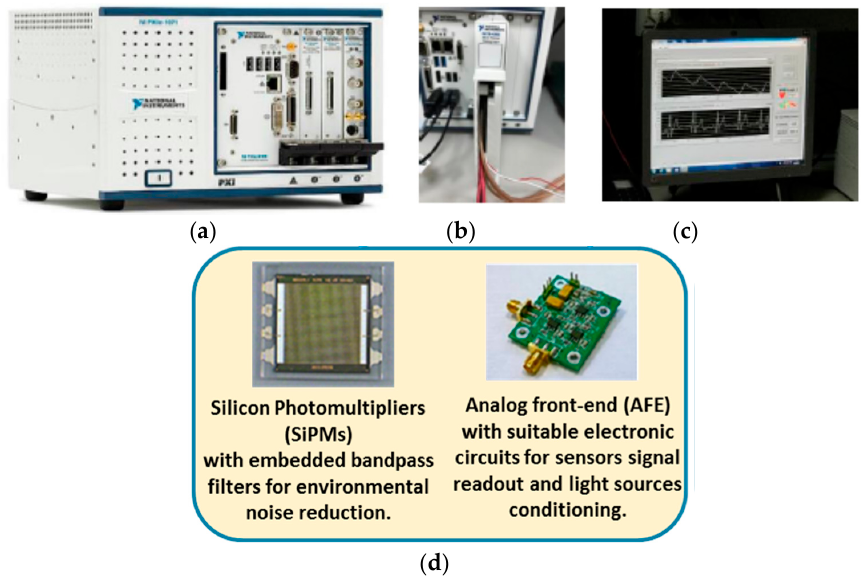
Figure 4. PPG probe hardware overview. ( a ) National Instrument (NI) device with acquisition board (containing 24 bit ADCs). Detailed ADC/DAC acquisition system of the NI device ( b ). NI system output during the acquisition of PPG and ECG signals ( c ). Such output is obtained by means of a software developed by NI in a LabView environment. Details of the SiPM sensor and electronic circuits for PPG signal filtering and transduction ( d ).